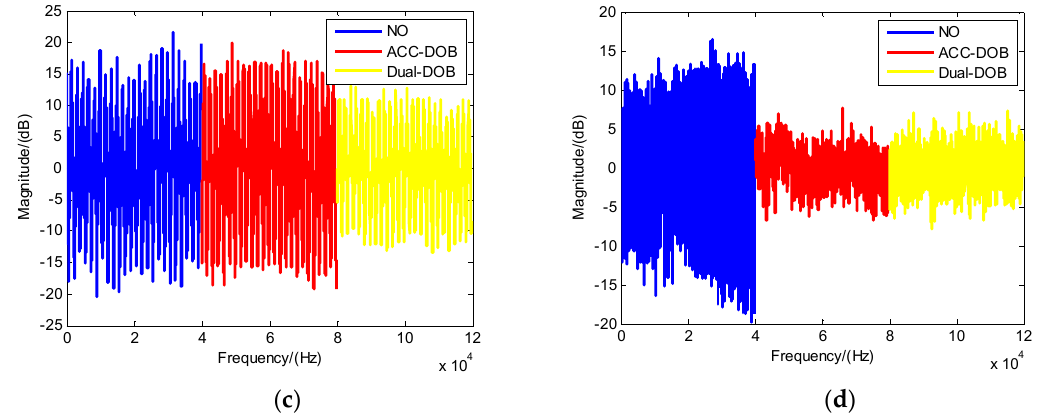
Figure 11. Time-domain error comparison of three structures. ( a ) Time-domain error comparison at a disturbance frequency of 1 Hz; ( b ) time-domain error comparison at a disturbance frequency of 2 Hz; ( c ) time-domain error comparison at a disturbance frequency of 3 Hz; and ( d ) time-domain error comparison at a disturbance frequency of 10 Hz. Table 1. Time-domain error, mean square, and peak comparison of three structures with disturbance frequencies of 1, 2, 3, and 10 Hz.